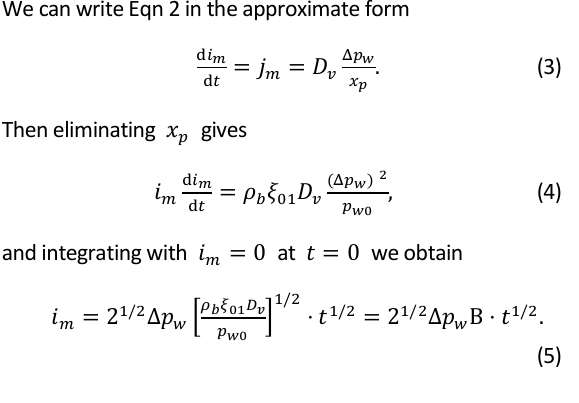
at the surface ; 𝐻𝐻 0 ′ AA 𝐻𝐻 1